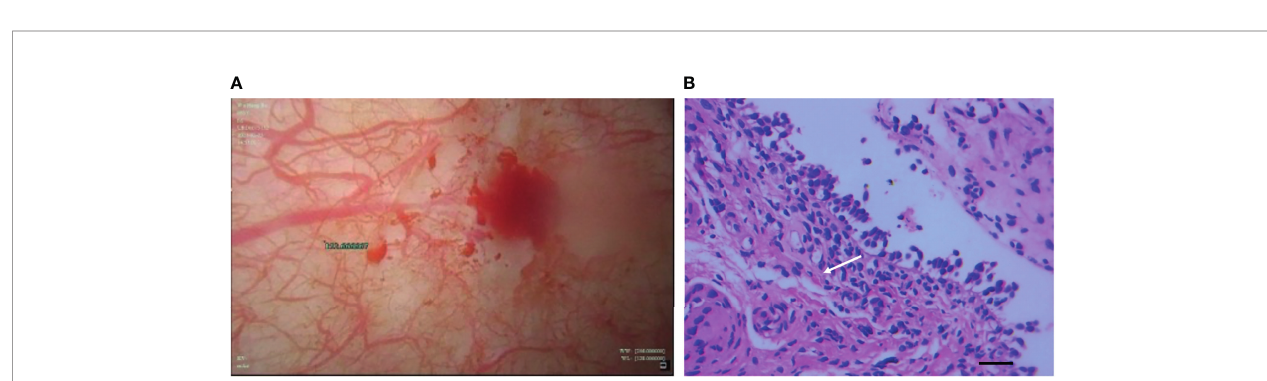
FIGURE 3 | Cystoscopy of bladder (A) revealed diffuse redness of bladder mucosa and histopathological fi ndings (B) of bladder biopsy showed lymphocyte- dominant bladder in fl ammation and interstitial tissue hyperplasia (white arrow), which was shown in the increased number of fi brocytes (H&E staining, magni fi cation ×400, bar =25 m m).